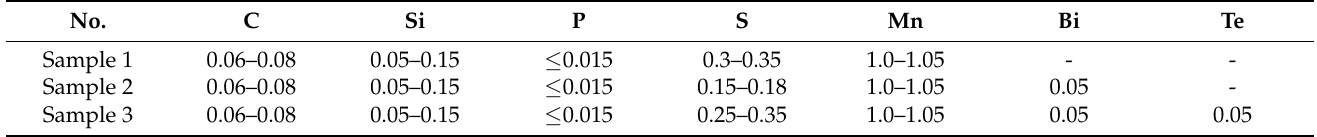
Table 2. Chemical composition design table of 3 groups of steel numbers,